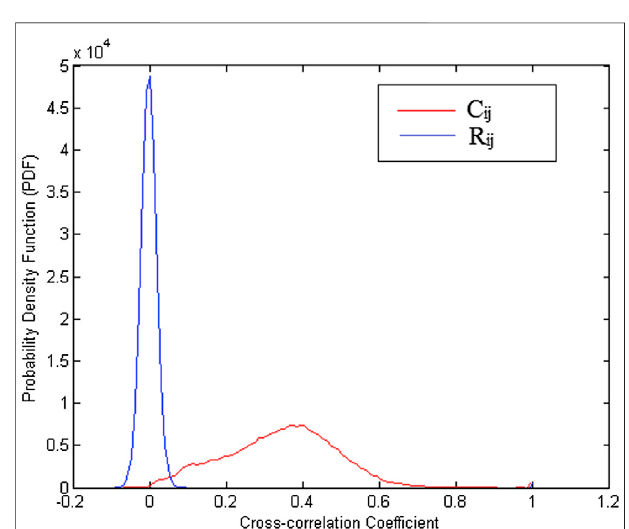
FIGURE 2 | Distribution of correlation coef fi cients of matrix C at three differenttimesintheS&P500dailystockpricedatafortheperiodofJanuary1, 2007untilOctober28,2016.Theblackcolorisforthetotalperiod2012 ‒ 2016 and it is decomposed into the green one for the period 2007 ‒ 2012 and theredonefortheperiod2012 ‒ 2016.Itshowshowtheblackonecontributes to the different distribution of the green and red ones.